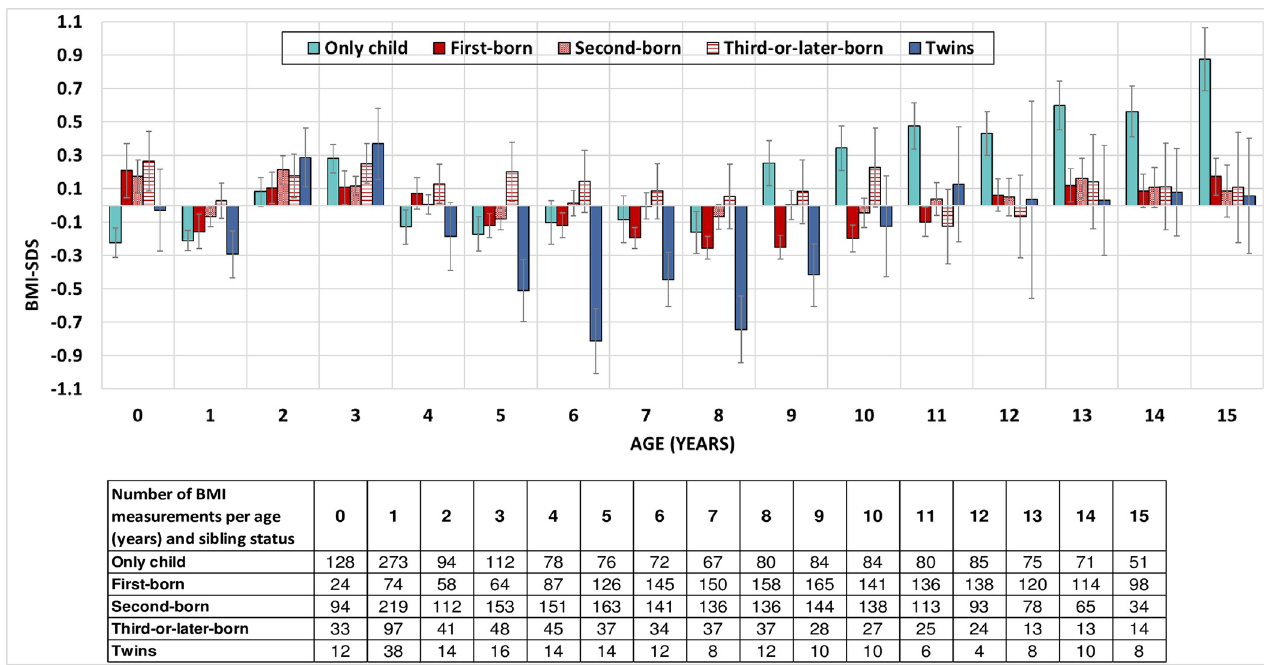
Fig 2. BMI-SDS by age and sibling status. BMI standard deviation scores at 1-yearintervals are shown according to sibling status: first-born, second-born, third-or-later-born, twins and only children. The values are means with a vertical error indicator (standard error of the mean). The number of measurements per age and sibling status is shown in the